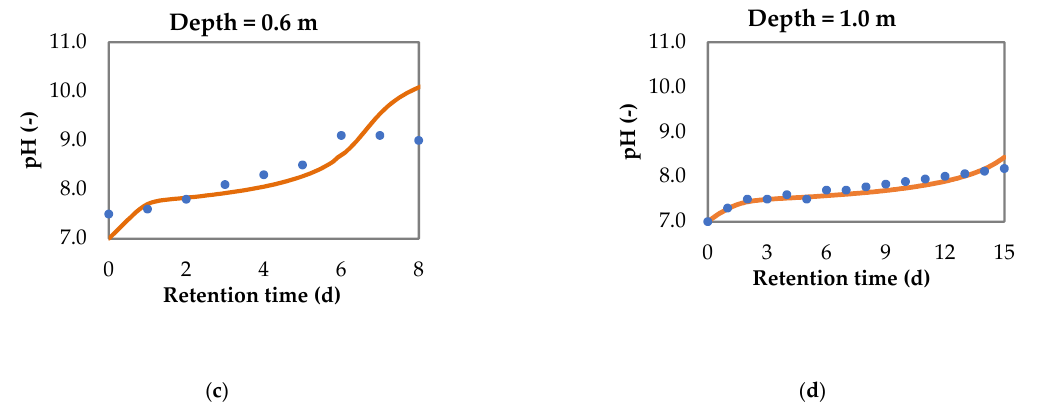
Figure 4. ( a ) Experimental data and simulated curve for pH as function of time for SBPP with a depth of 0.2 m; ( b ): Experimental data and simulated curve for pH as function of time for SBPP with a depth of 0.4 m, ( c ): Experimental data and simulated curve for pH as function of time for SBPP with a depth of 0.6 m, ( d ): Experimental data and simulated curve for pH as function of time for SBPP with a depth of 1.0 m.